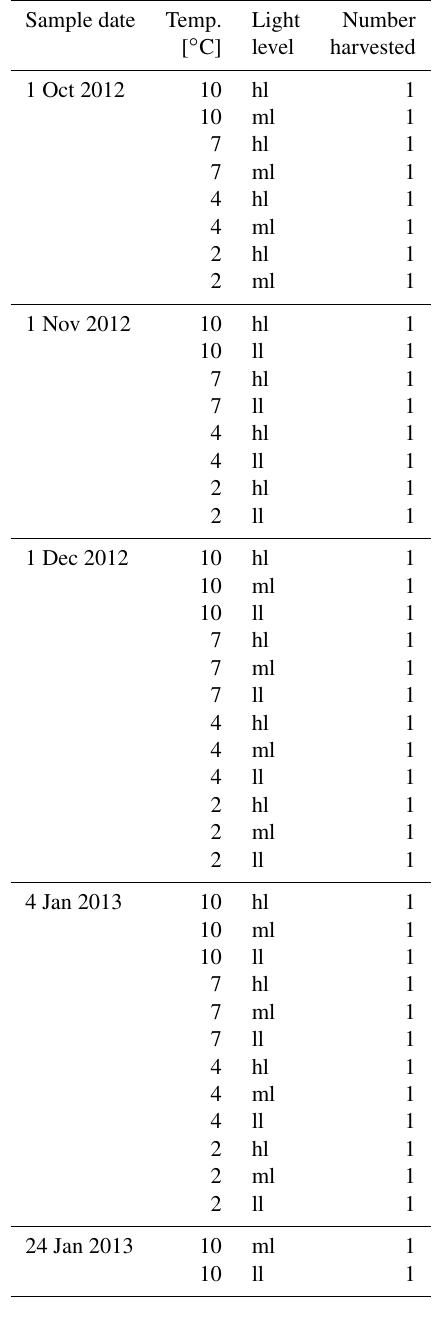
Table 2. C. compactum growth experiment (ClEx) at Logy Bay, Newfoundland. Specimens collected in mid-August 2012 and brought to experimental temperature through September 2012. High light (hl) was <400lx, medium light (ml) was <160lx, and low light (ll) was